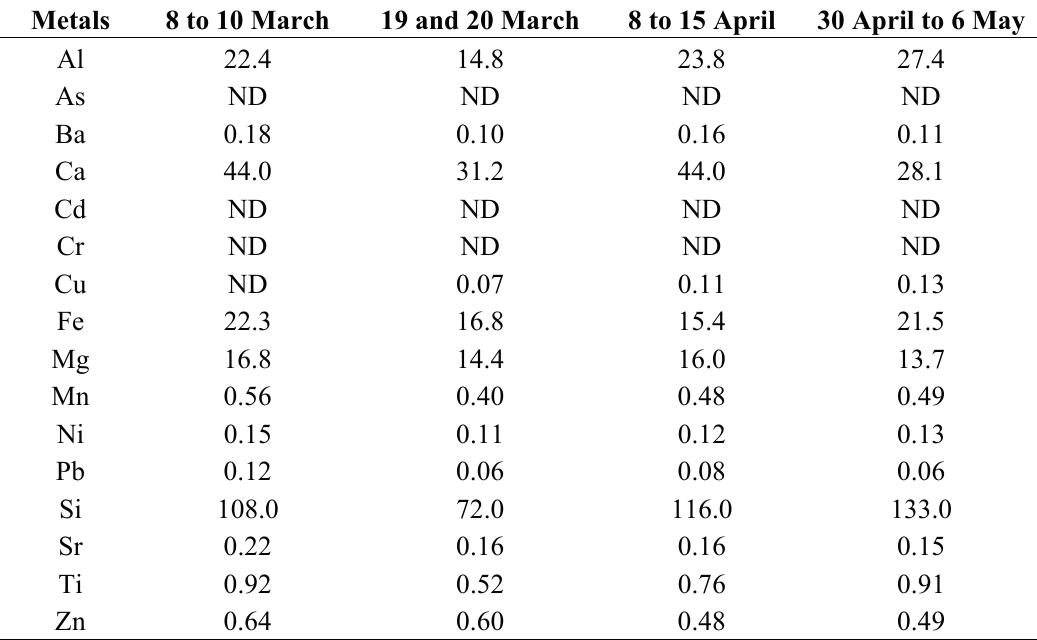
Table 1. Concentration of metal elements ( μ g/mg) in collected airborne